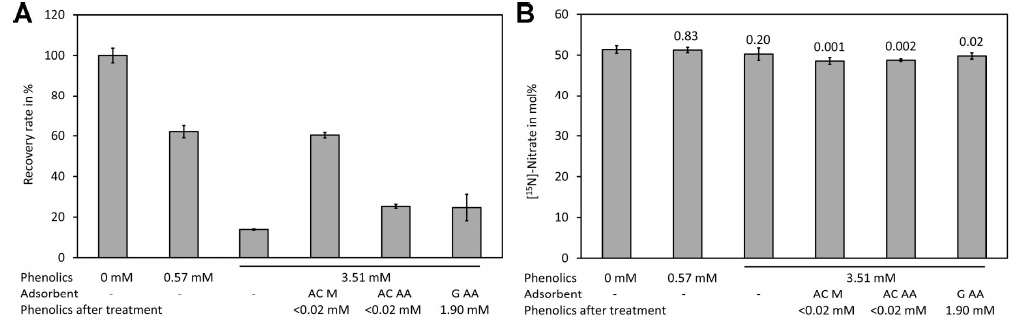
Figure 5. Chromatograms. ( A ) Chromatogram of a standard containing 0.2 mM [ 14 N]-nitrate. ( B ) Chromatogram of a standard containing 0.2 mM [ 15 N]-nitrate. ( C ) Chromatogram of a plant sample grown on medium containing [ 15 N]-nitrate and shifted to medium containing [ 14 N]-nitrate 3 days prior analysis. ( D ) Chromatogram of a blank. Original data are presented in Supplementary File S5.